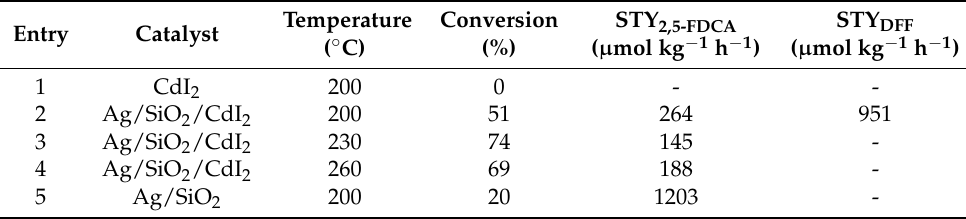
Table 2. Influence of temperature for the 2,5-FDCA synthesis using Ag/SiO 2 and CdI 2 mixture on the K2F conversion and space–time yields (STY).